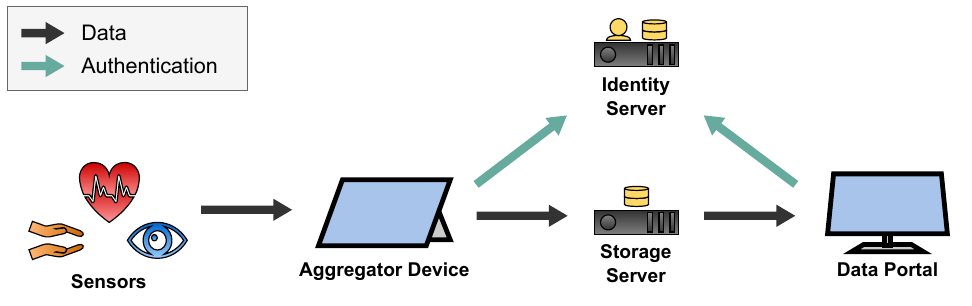
Figure 17. Recording Architecture of the SKS.